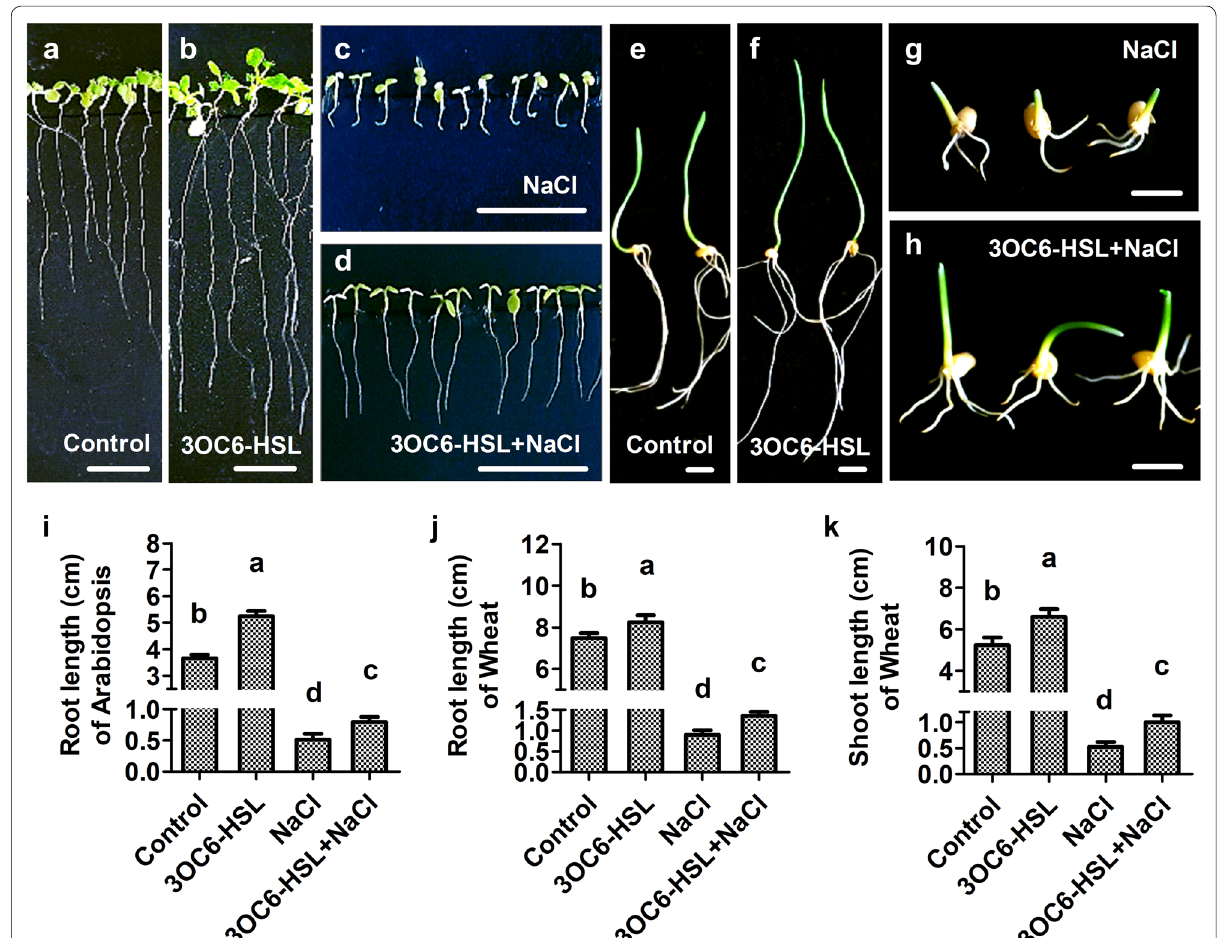
Fig. 2 Effect of 3OC6‑HSL on root growth in Arabidopsis and wheat. Seedlings were treated with 1 μM 3OC6‑HSL or/and 150 mM NaCl after seeds germination. The changes of root phenotype were observed after 6 days treatment in Arabidopsis and wheat. a , e Non‑treated control plants; b , f 3OC6‑HSL treated plants; c , g NaCl treated plants; d , h 3OC6‑HSL and NaCl co‑treated plants; i root length of Arabidopsis; j root length of wheat; k shoot length of wheat. bar 1 cm, values are mean SD of three independent experiments. Different letters indicate statistically significant = ± differences ( P < 0.05, Duncan’s